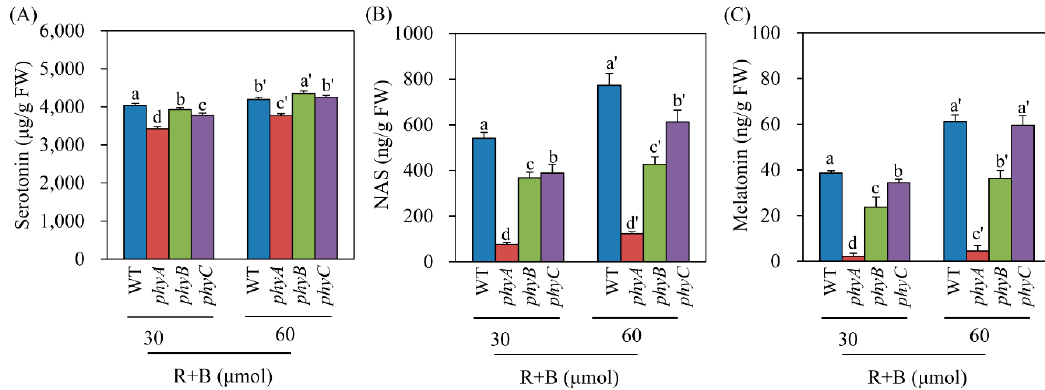
Figure 5. Effects of light intensity on ( A ) serotonin, ( B ) N -acetylserotonin, and ( C ) melatonin levels in phy mutants in response to cadmium treatment under two light intensity conditions. Seven-day-old rice seedlings were rhizosperically challenged with 0.5 mM CdCl 2 for 3 days under two different continuous light intensity conditions. Light intensity (R + B) was either 30 or 60 μ mol × m − 2 × s − 1 . Values are means ± standard deviations of three independent experiments. FW, fresh weight. Different letters denote significant differences as determined by Tukey’s post hoc HSD test at P < 0.05.